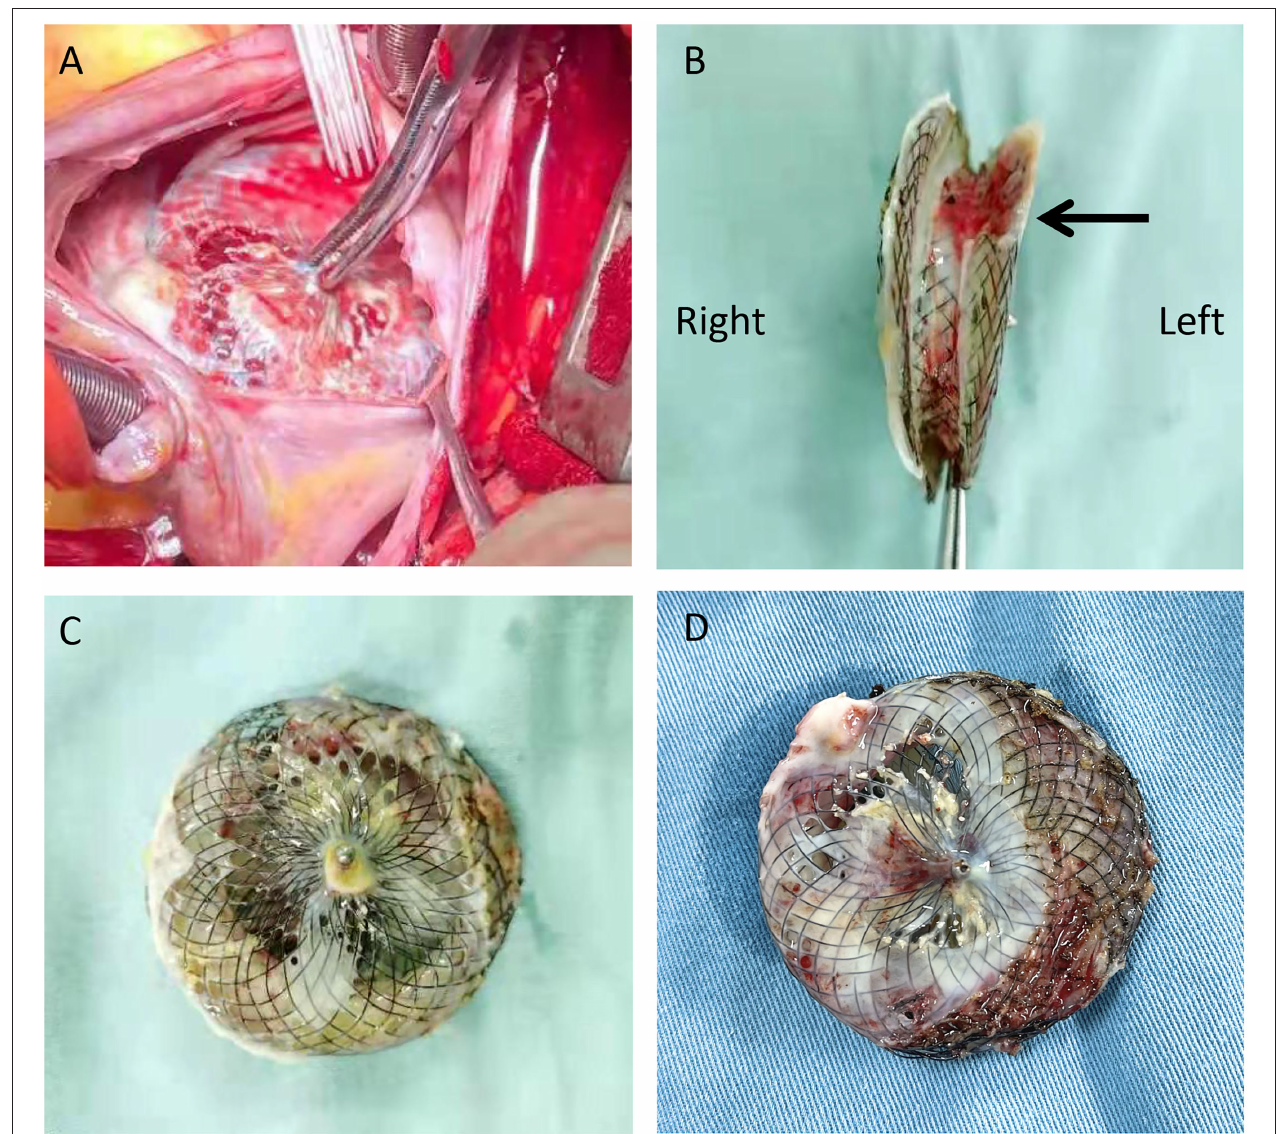
FIGURE 2 | Intraoperative view of the procedure: After opening the right atrium, a deformed occluder was found in the atrial septum (A) ; the left side of the occluder was damaged more obvious than the right [ (B) , arrow]; The PVA membranes showed multiple perforations and were partly dissolved, and the diameter of the largest void was around 10mm (C,D)